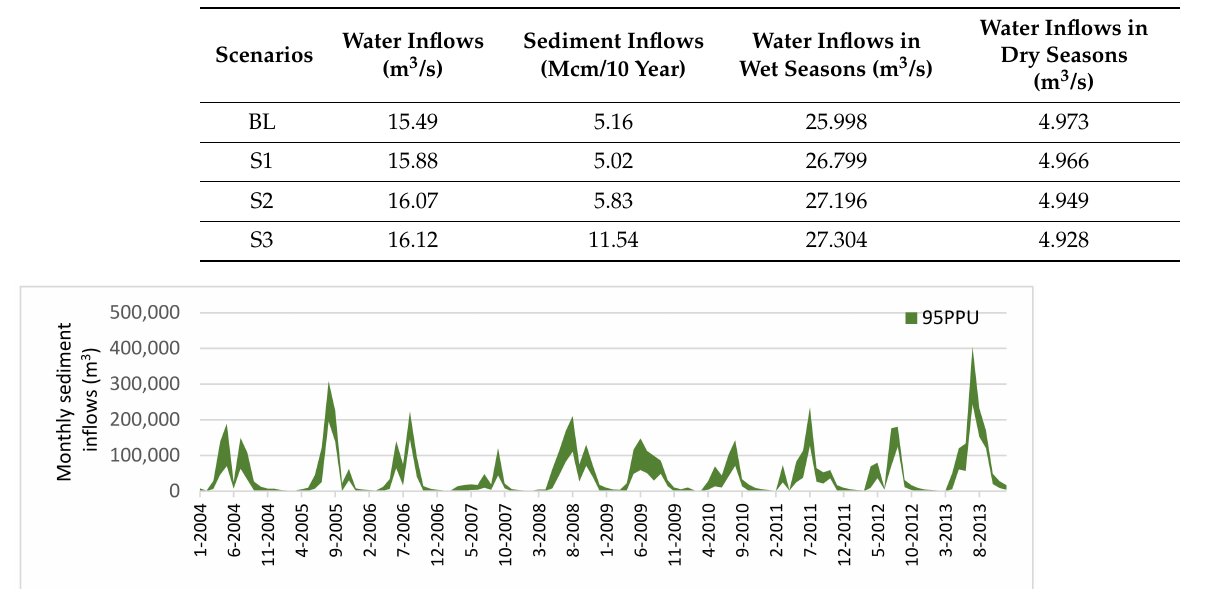
Table 3. Water inflows to the reservoir over a 10-year simulation (extracted from the median of 95PPU).